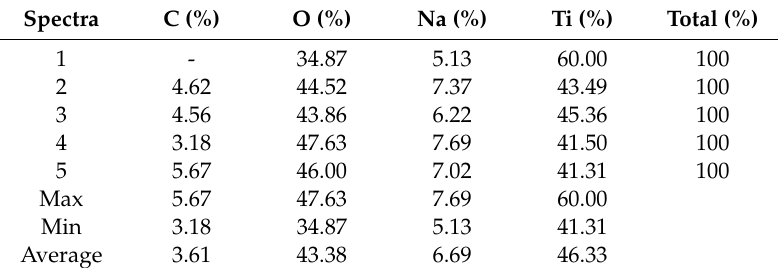
Figure 11. EDS analysis of the modified catalyst SL400. Table 6. EDS results in % weight in the modified catalyst.